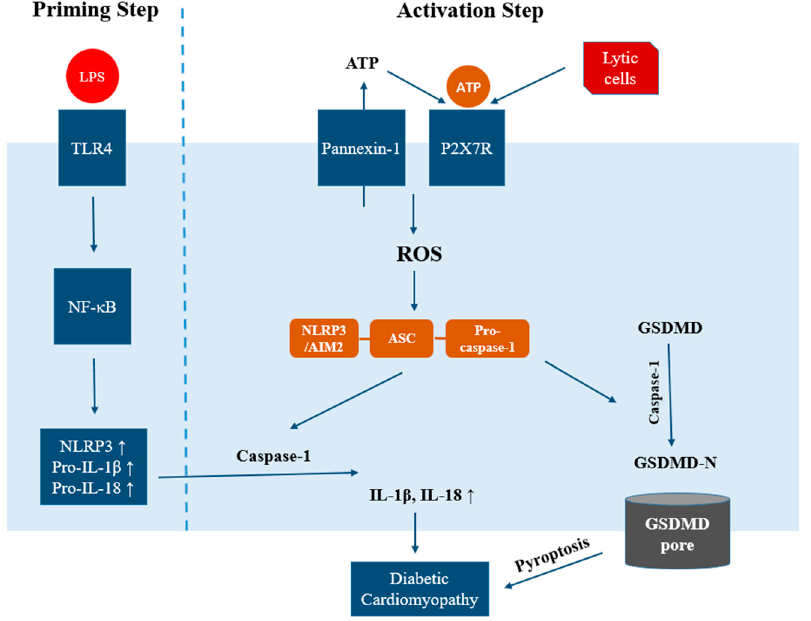
Figure 2. Schematic summary of the involvements of P2X7R, NLRP3 inflammasome and pyroptosis in DCM. Two steps are required for the processing and release of the mature form of IL-1 β and IL-18. In the first (priming) step, recognition of inflammatory stimuli by the membrane receptor TLR4 triggers the activation of NF- κ B, which then induces transcriptions of NLRP3, pro-IL-1 β and pro-IL-18. In the second (activation) step, an activation signal triggers assembly of the NLRP3 in- flammasome. Caspase-1 then mediates the maturation and secretion of IL-1 β and IL-18. In addi- tion, caspase-1 cleaves GSDMD to release GSDMD-N, which generates membrane pores. The re- lease of IL-1 β and IL-18, as well as pyroptosis, together contribute to the pathogenesis of DCM. In DCM, the NLRP3 inflammasome is possibly activated via P2X7R. A high level of ATP released from Pannexin-1 channels activates P2X7R, generating excessive ROS and promoting NLRP3 as- sembly. 3. Exercise Intervention for Diabetic Cardiomyopathy If hyperglycemia is not corrected, diabetic patients might end up with cardiac hy- pertrophy and myocardial dysfunction [60]. Physical activity is a basic treatment rec- ommended for diabetic patients [61]. A meta-analysis based on twelve aerobic training studies and two resistance training studies revealed that exercise training could effec- tively lower the HbA1c level, even when body mass was not significantly altered [62]. Moreover, exercise training of more than 150 min per week was associated with greater HbA1c decline [63]. 3.1. Exercise Intervention to Regulate the NLRP3 Inflammasome It is well known that regular physical activity exerts many health benefits, partly through regulating inflammation. The NLRP3 inflammasome plays an important role in innate immunity by responding to various microbial and endogenous products, and its structure and function is also tightly modulated by exercise intervention (Table 1). The NLRP3 inflammasome seems to be activated during the early stage of acute ex- ercise, as well as during the recovery period. The expressions of NLRP3 and IL-1 β in mice myocardium were increased following 45 min acute exercise, and at 12 h and 24 h post exercise [64]. However, NLRP3 and IL-1 β were not different from the resting level fol- lowing 90 min or 120 min exercise, or at 36 h or 48 h post exercise. It is generally accepted that mitochondrial ROS is a potent activator of the NLRP3 inflammasome. However, the fact that upregulations of NLRP3 and IL-1 β take place early during acute exercise, and that a surge of ROS generation comes next suggest that ROS and NLRP3 might form a